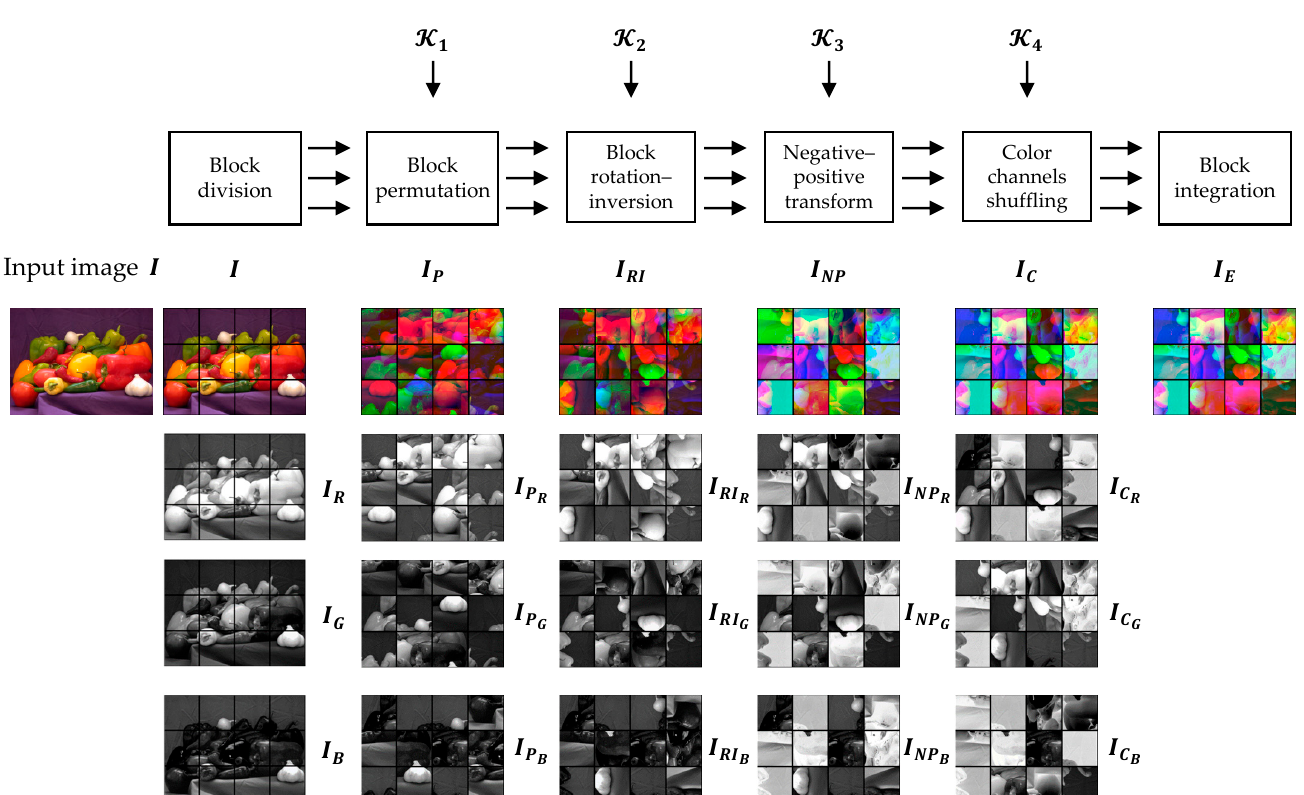
Figure 5. The encryption algorithm steps of an Extended CPE scheme. For visual analysis, the e ff ect of each transformation function on the image is shown across each color channel. The keys 𝓚 𝒊 , 𝑖 = 1, … , 4 is a set of keys used in each step to process the color channels. Each color component is processed independently; therefore, the blocks have di ff erent appearances.